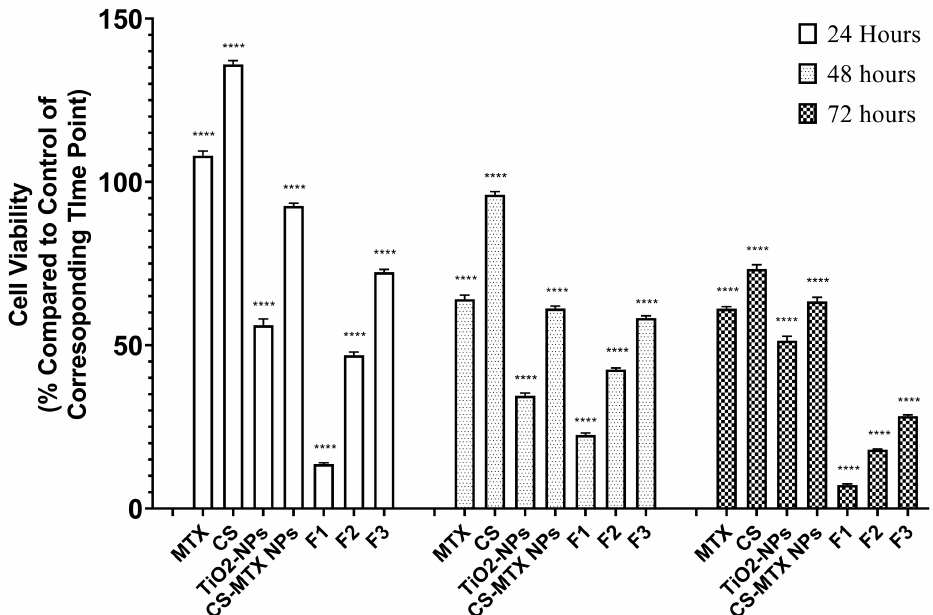
Figure 6. The cell viability of MTX, CS, TPP, TiO 2 NPs, CS-MTX NPs F1 (1:1), F2 (1:2) and F3 (2:1) (the ratio of MTX-CS-NPs to TiO 2 ) on MCF-7 cell line after 24, 48, and 72 h of incubation.Groups were compared using two-way ANOVA. (ns: p > 0.05; *: p ≤ 0.05; **: p ≤ 0.01; ***: p ≤ 0.001; ****: p ≤